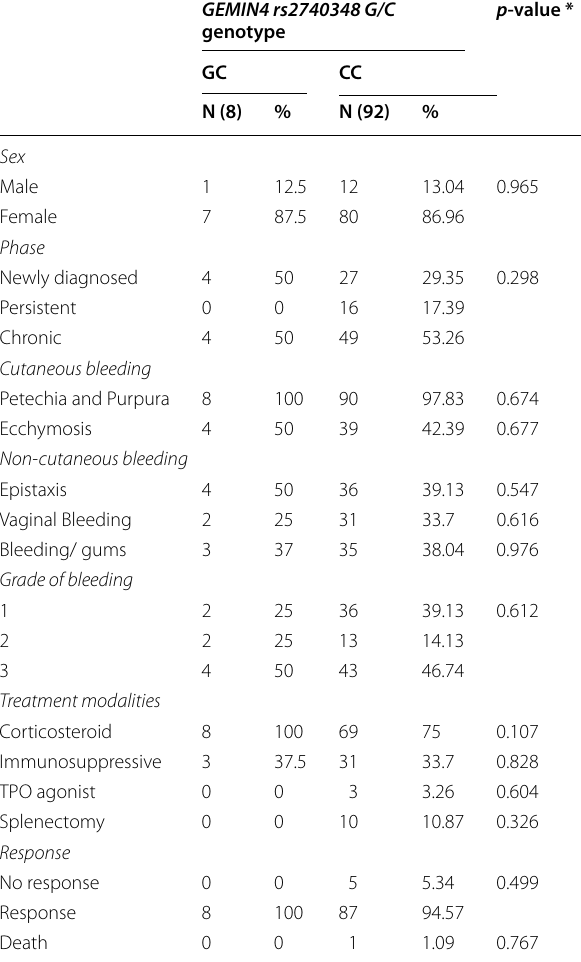
Table 4 rs2740348 G/C genotypes frequencies